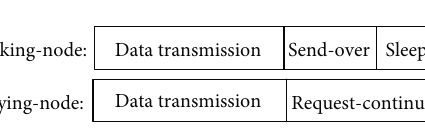
Figure 6: Working node and busying